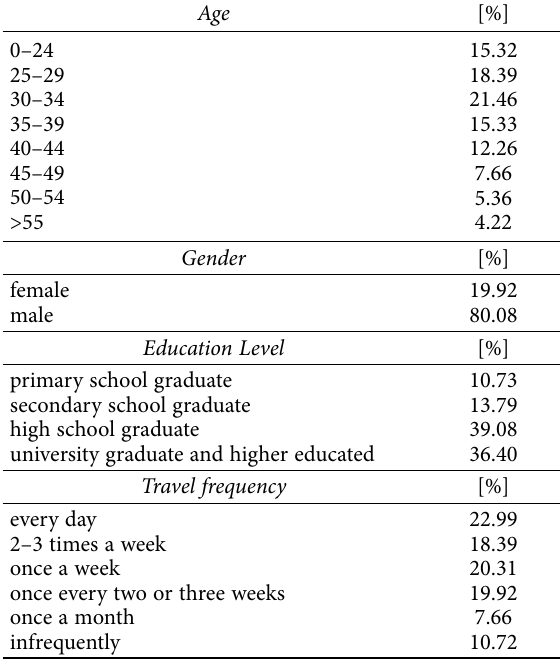
Table 3. Distribution of demographic data of interviewed